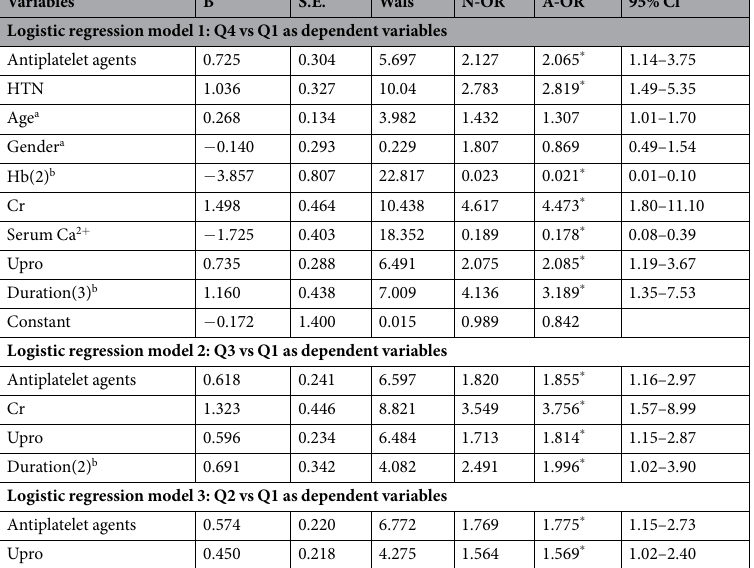
associated RDW since the lower Q1 of RDW showed the higher level of serum Ca 2 + (Table 2). A possible explana- tion is that higher serum Ca 2 + may increase the deformability of red cells, leading to reduced RDW.